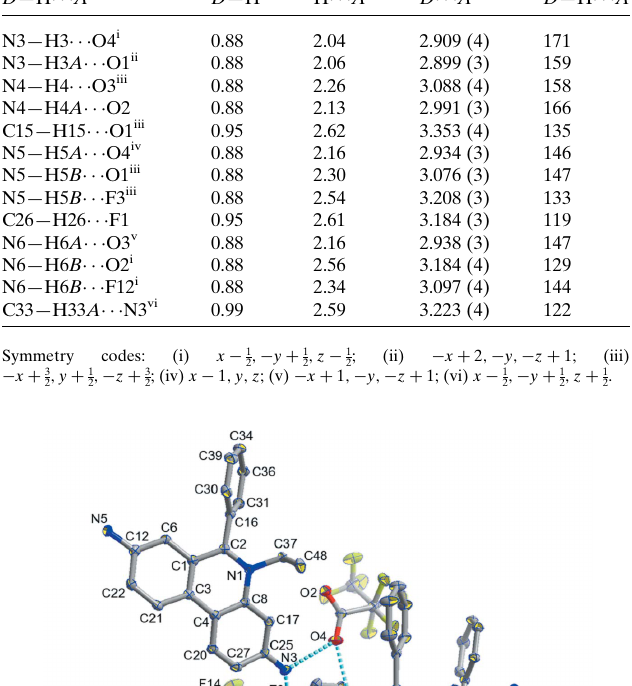
Table 2 Experimental details. Crystal data Chemical